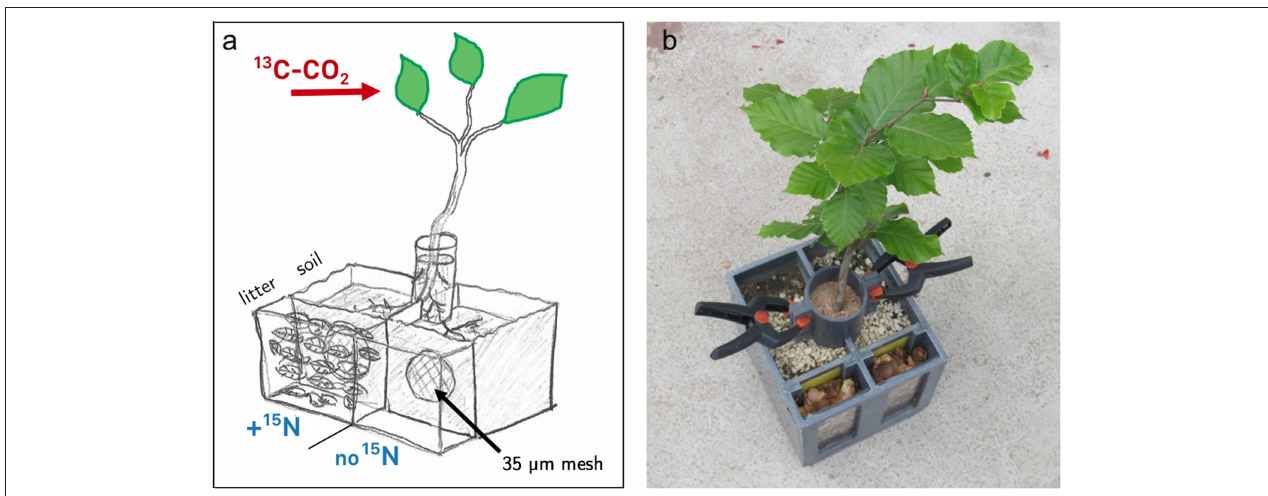
FIGURE 1 | Design of split–root boxes. Plants grew in two separated soil compartments where the root system was divided into two halves. Stems were stabilized in a cylinder filled with quartz sand. Each soil compartment was connected to a leaf litter compartment, separated by a mesh (35 µ m) which is penetrable by fungal hyphae, but not by roots. Plant canopies were exclusively exposed to a 13 C-CO 2 enriched atmosphere. A mixture of 15 N-labeled ammonium and amino acids was added to only one litter compartment per box. (a) Schematic drawing of the setup. One of the two litter compartments is drawn without litter to illustrate the chamber design with the separating mesh. For the experiment both outer compartments were filled with beech litter. (b) Photo of a plant used in the labeling experiment.